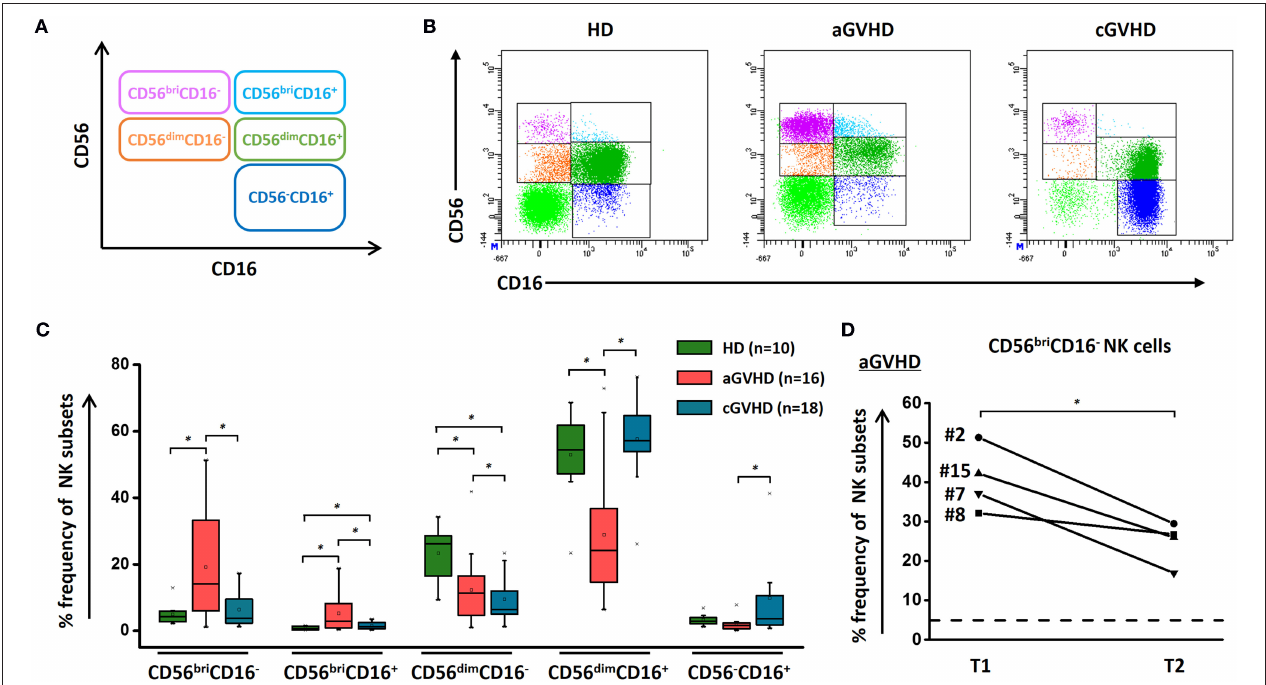
FIGURE 1 | NK subsets in GVHD and effect of ECP on CD56 bri NK subset. NK cells could be defined as five different subsets by relative expression of CD56 and CD16 (A) . The representative dot plots (B) and box plots (C) show that the component of NK cells is different among aGVHD patients ( n = 16), cGVHD patients ( n = 18), and HDs ( n = 10). ECP could dramatically decrease the frequency of CD56 bri CD16 − NK cells in aGVHD patients with CR ( n = 4) (D) . Dashed line represents the corresponding median value of frequencies observed in 10 healthy donors. * p <